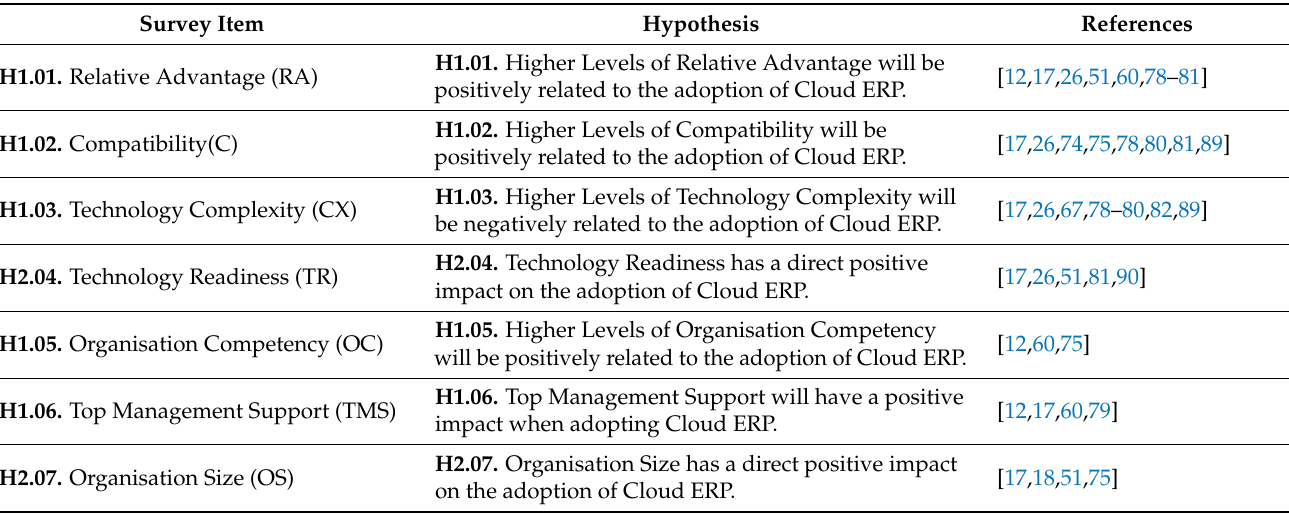
Table 5. Hypothesis